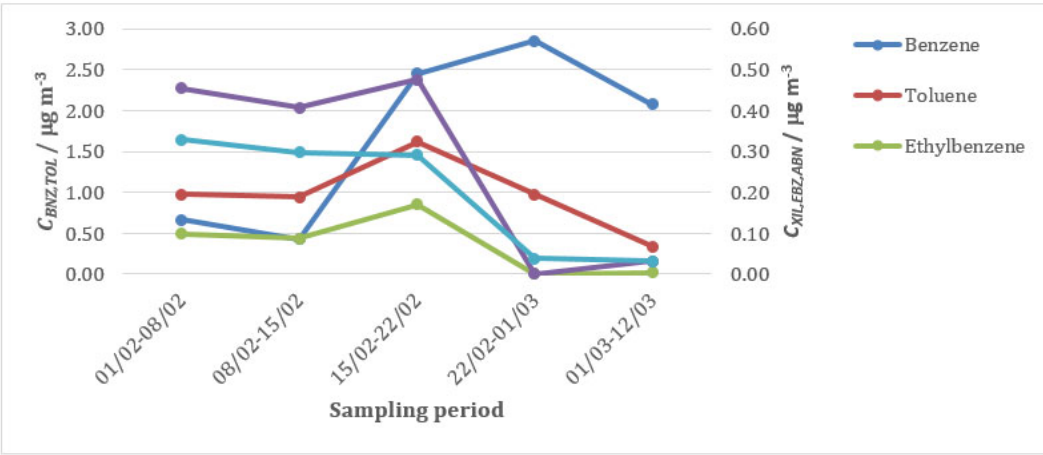
Figure 5. Mean VOC concentration values for each sampling period on site 4E (classroom 4E).